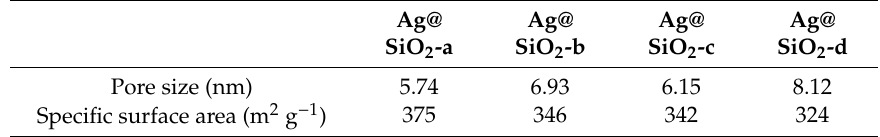
Table 2. Pore size and specific surface area of Ag@SiO 2